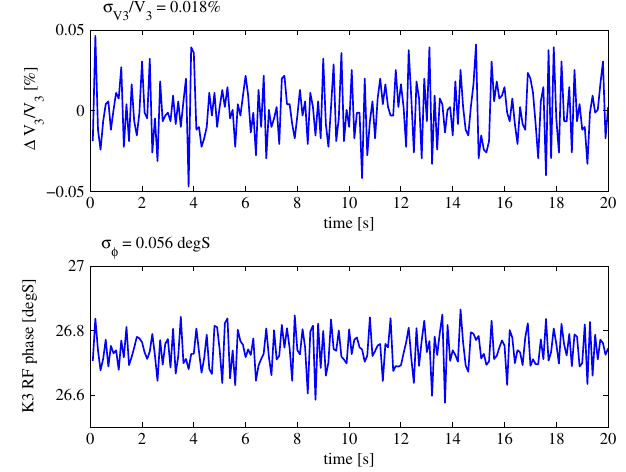
FIG. 5. The relative rf amplitude (top) and rf phase jitter (bottom) of the K3 klystron in L1 rf section measured over 20 sec at a 10 Hz sample rate (feedback